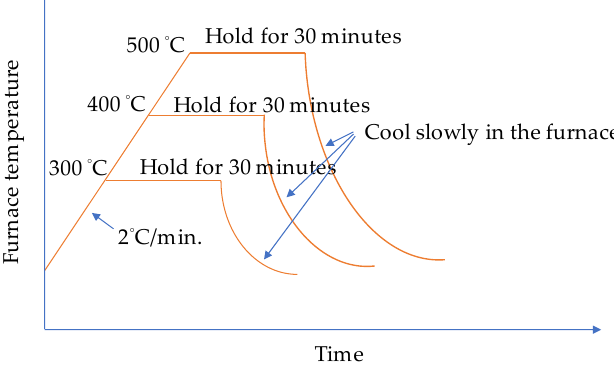
Figure 5. The heating process of the high-temperature test.